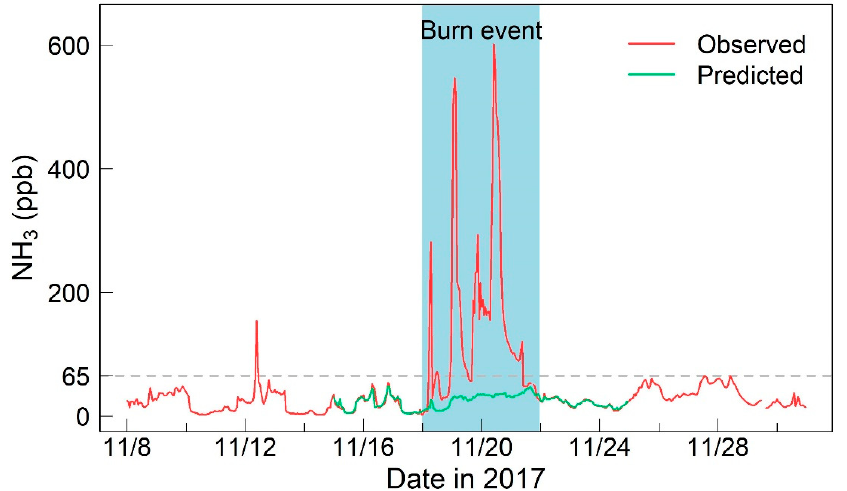
Figure 2. Temporal variation in hourly concentrations of NH 3 . The gray line indicates an NH 3 concentration of 65 ppb. The blue shaded area represents the burning period, and the non-shaded area represents the nonburning period.